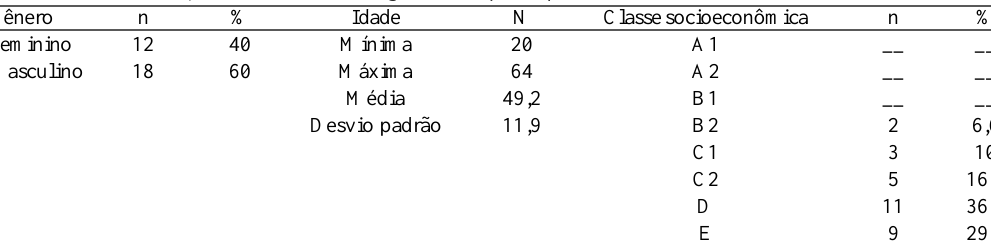
Tabela 1. Perfil etário, socioeconômico e de gênero dos participantes.